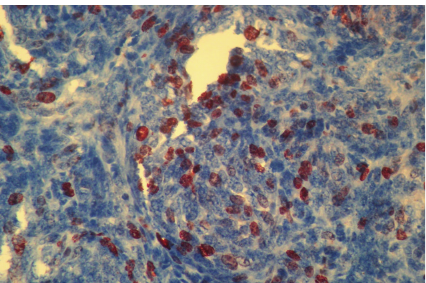
Figure 3: Immunohistochemically tumor cells were positive for cytokeratin and